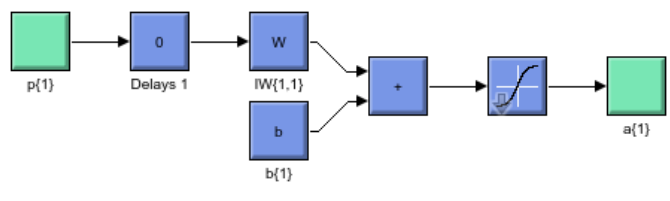
Figure 6. Layer 1 architecture. The diagram of torque and flux control is based on the proposed twelve-sector DTC with the ANN algorithm and is presented in Figure 7.